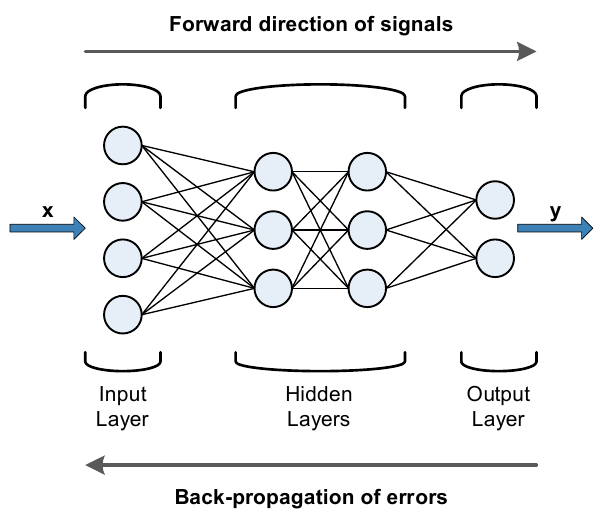
Figure 2. A three-layer 4-3-3-2 back-propagation neural network (BPNN) (input typically not counted as a layer).